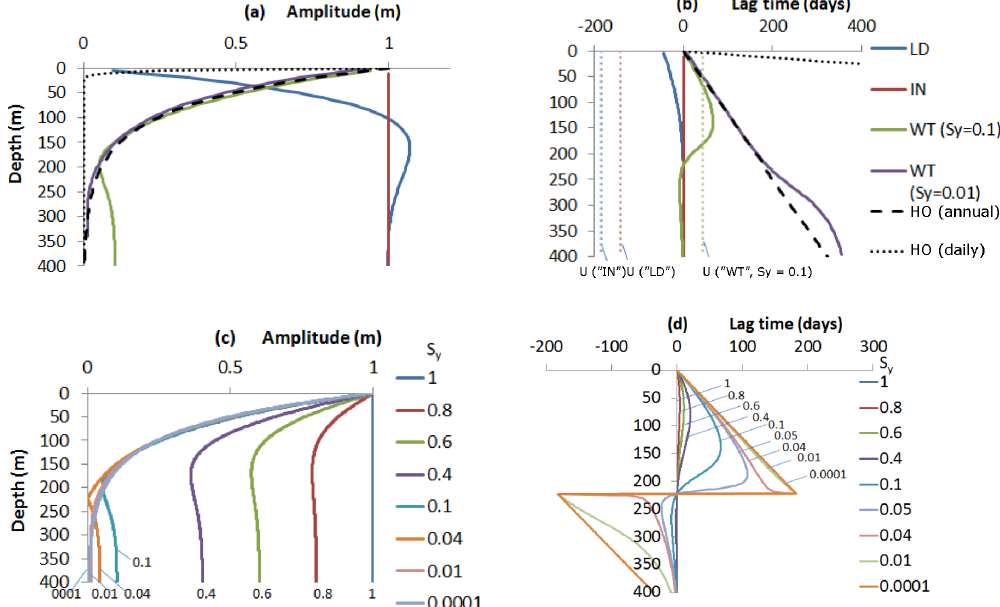
Figure 5. Profiles with depth for (a) amplitude of head response, (b) phase of head response and surface displacement ( U ), (c) sensitivity of amplitude to S y for the “WT” boundary condition, and (d) sensitivity of phase to S y for the “WT” boundary condition. For panels (a) and (b) , the colour code for scenarios “LD”, “IN”, “WT” ( S y = 0 . 1), ‘WT” ( S y = 0 . 01), and HO is shown in panel (b) (see text for explanation); in panel (b) , displacement for the WT, S y = 0 . 01, scenario overlies that for the WT, S y = 0 . 1 scenario, and so is not shown. (Note: in the instance that ξ is not close to 1, S y in these plots can be substituted by γ = S y ξ